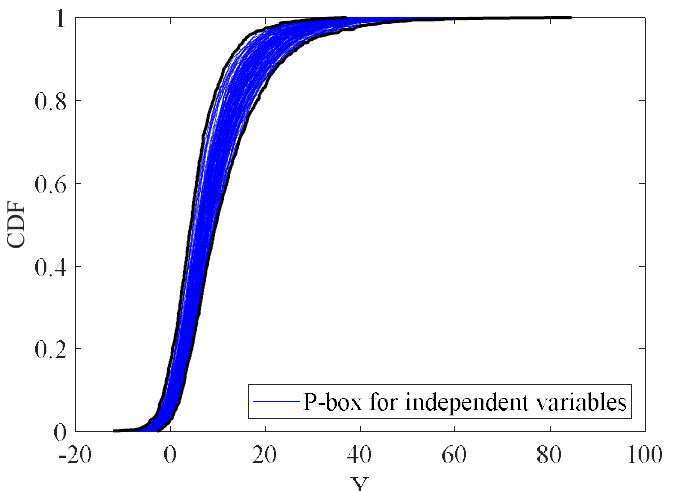
Figure 11. The p−box for the system analytical function with independent variables after affine Figure 11. The p-box for the system analytical function with independent variables after affine transformation. transformation.